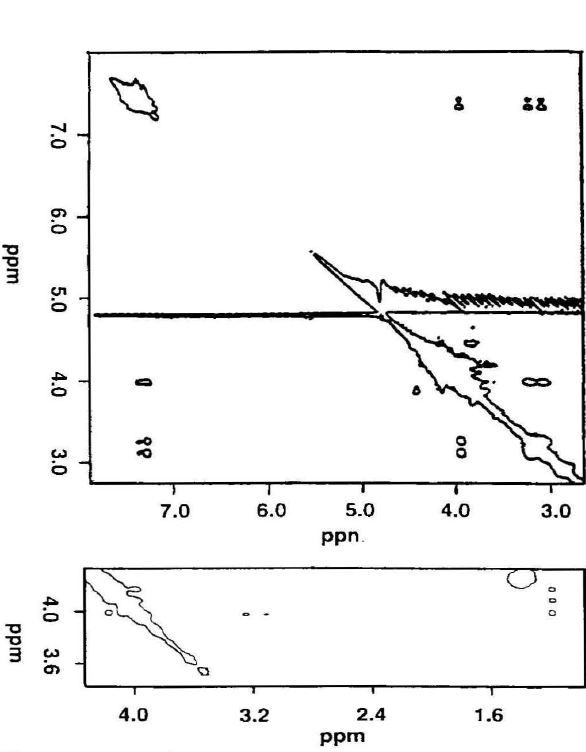
Figure 2. Two-dimensional nuclear Overhauser effect (NOESY) spectra of L-Phe and L-erythro·7,8-dihydrobio pterin (BH 2) in the presence ofTH1. The 400-MHz 'H NMR spectra were taken at 273 K in samples (0.5 ml) prepared in D 2 0 containing 0.3 mM THl, 5 mM BH 2, 5 mM L-Phe, 0.3 mM ZnCh, 0.1 M KCl and 0.1 M deu terated K-phosphate at pH* 7.4. The mixing time was 100 ms; other parameters given in the Materials and Me thods section. (Upper) Region showing cross-peaks between resonances of L·Phe. (Lower) Region showing cross·peaks between the H7, HI' and H2 ' and the methyl resonance of BH 2• dicates that the cross-relaxation rate of the H2,6- H3,5 protons of L-Phe, separated by 2.46± 0.02 A (20), can be used as a reference to calculate the intramolecular proton distances both in BH2 and L-Phe (Table 2).